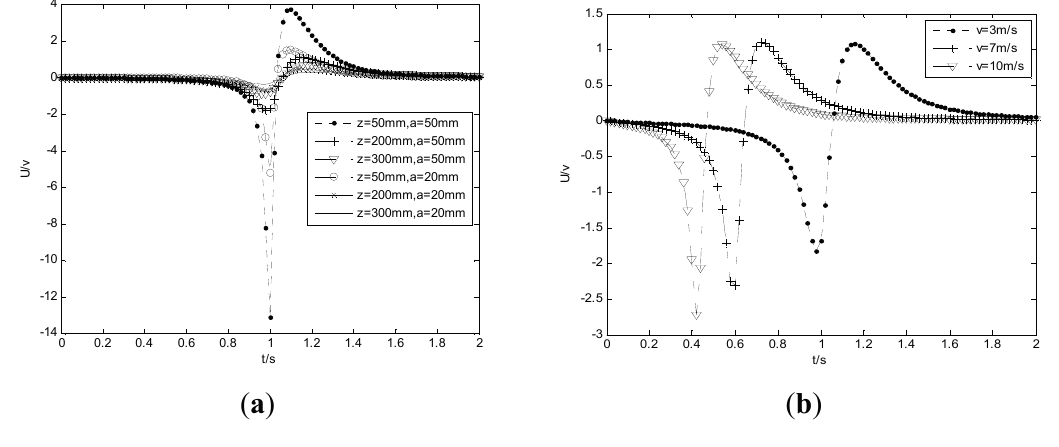
Figure 13. System time responses for different